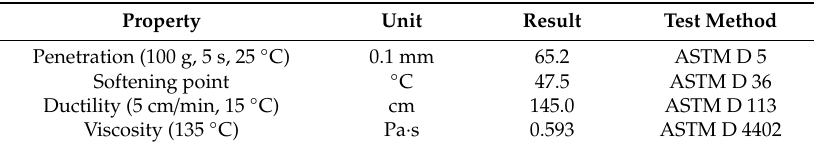
Table 1. Basic properties of the base asphalt binder.